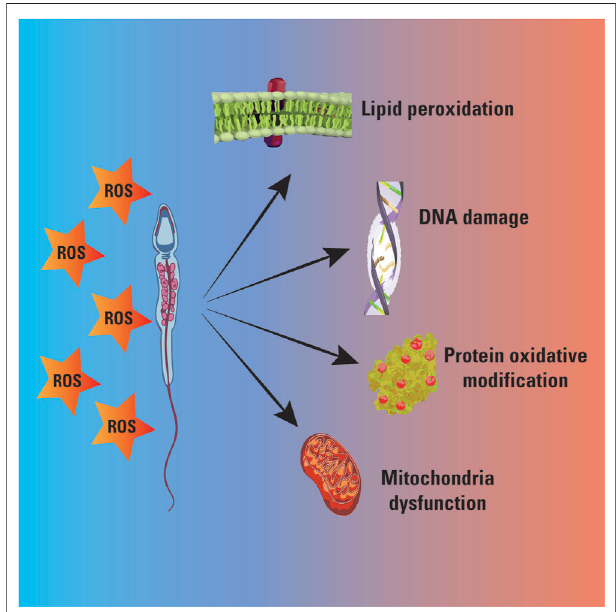
FIGURE 1 | Oxidative stress negatively affects sperm cells causing mitochondrial injury and alterations in lipids, nucleic acids and